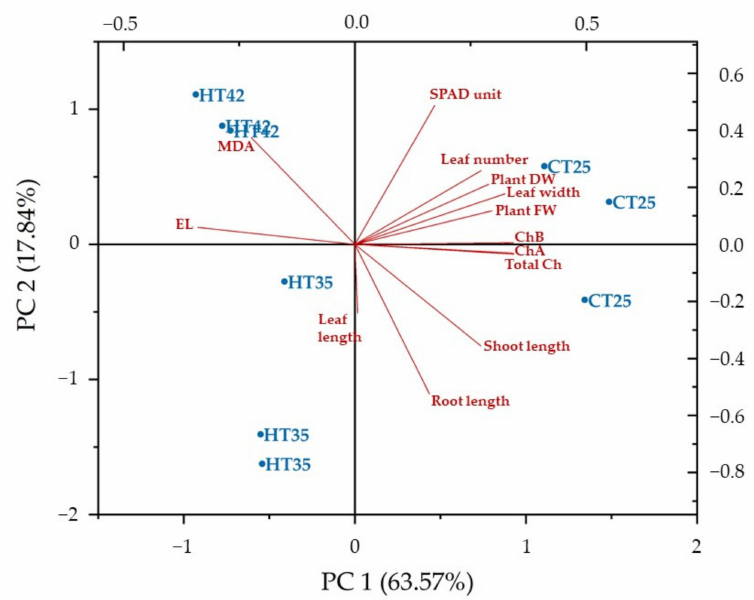
Figure 3. PCA biplot for PC1 and PC2 representing the relationships between KDML105 seedlings and growth and physiological parameters recorded from the control and heat stress